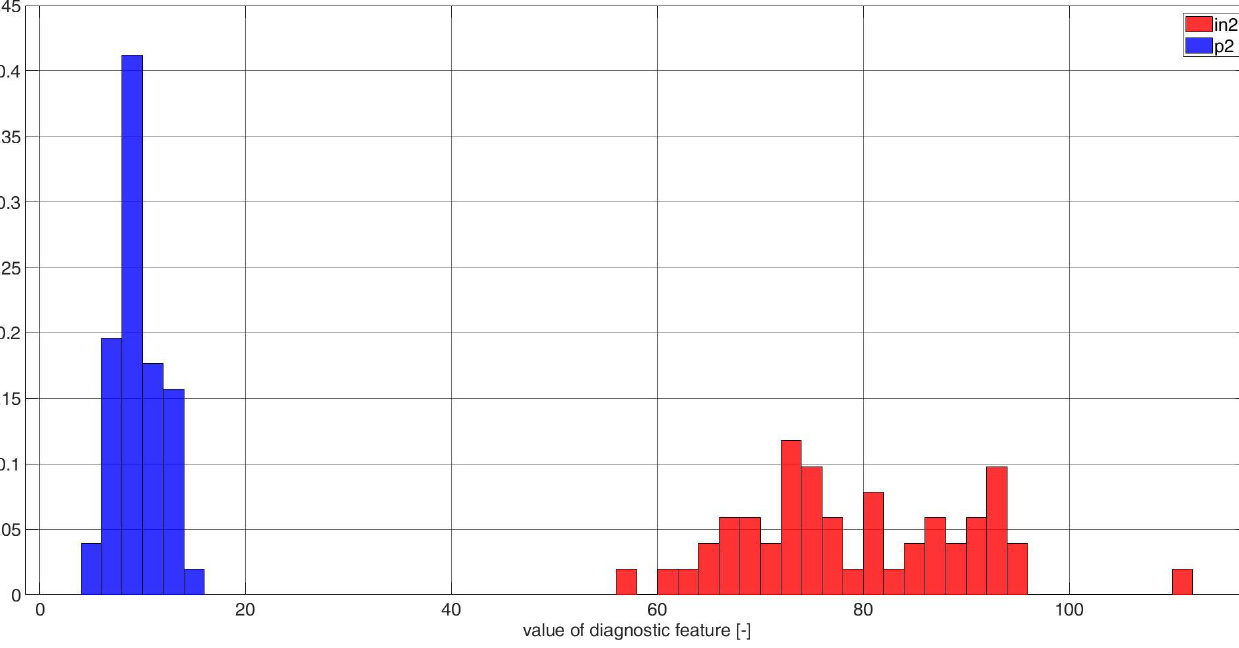
Figure A10. Histograms of diagnostic features based on the CCSM3 (correlation number is 8 — Table A1) bearings in2 and p2.